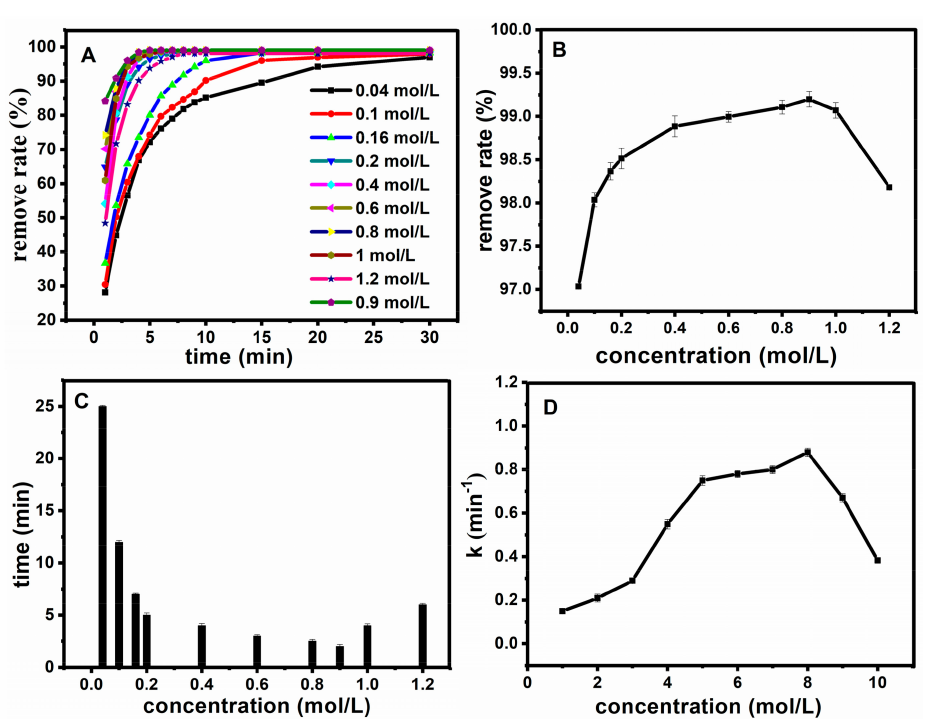
Figure 7. Effect of H 2 O 2 concentration on oxidation rate ( A ); The relationship between the concentration of H 2 O 2 and the removal degree after 30 min ( B ); the relationship between the hydrogen peroxide concentration and time when the removal degree reached 98% ( C ); the relationship between the concentration of hydrogen peroxide and the work rate ( D